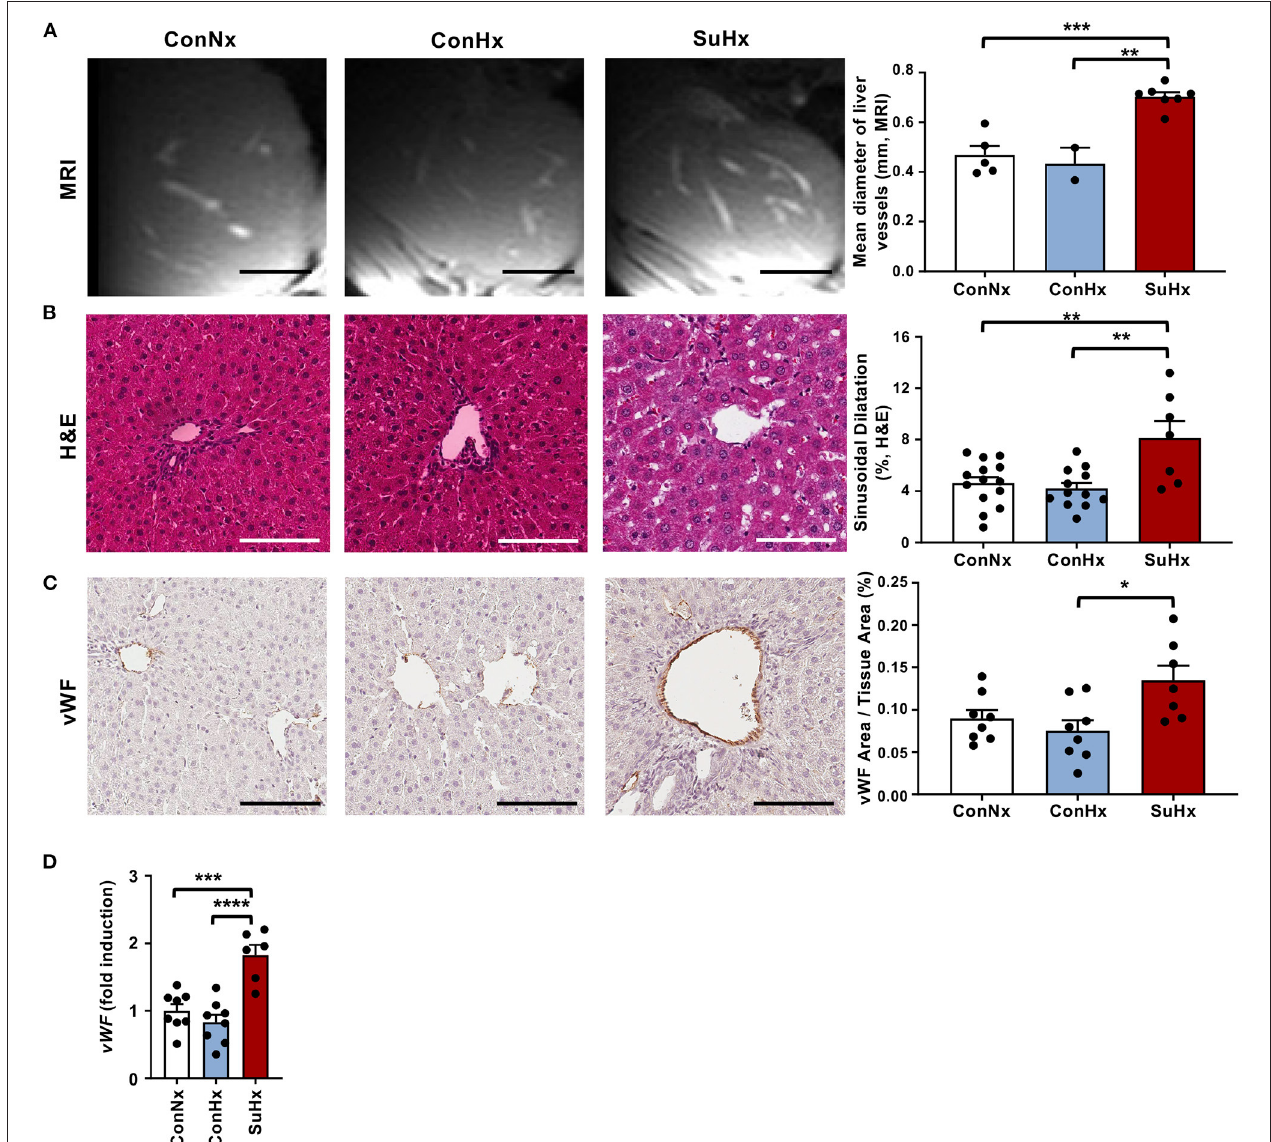
FIGURE 2 | PAH rats show signs of hepatic congestion. (A) Representative MRI images and quantification of mean diameter of visible liver vessels in the livers of the different treatment groups. Scale bars 5mm (B) Representative pictures and quantification of vessel area of Hematoxylin and Eosin (H&E) stained livers of analyzed rats. (C) Representative pictures and quantification of IHC for vascularization marker von Willebrand factor ( vWF ). (D) Relative expression of von Willebrand factor ( vWF ) determined by qPCR from whole livers. Means ± SEM, ConNx n = 8–13, ConHx n = 8–12, SuHx n = 7, ANOVA-Bonferroni post-hoc test, * p < 0.05, ** p